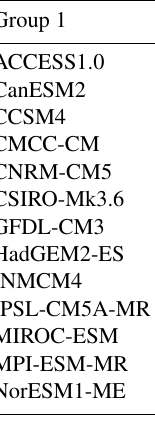
Table 1. Models used in the present analysis. Most of the analysis was conducted using the models in group 1. Additional investiga- tions described in Sect. 3.3 were conducted using the models in both group 1 and group 2 to determine inter-model robustness of the dif- ferent pattern scaling methods discussed in this study. All model names listed are the standard names used in contributions to the Coupled Model Intercomparison Project Phase 5 (CMIP5; Taylor et al., 2012). Knutti et al. (2013) provide an excellent description of these models and their provenance.